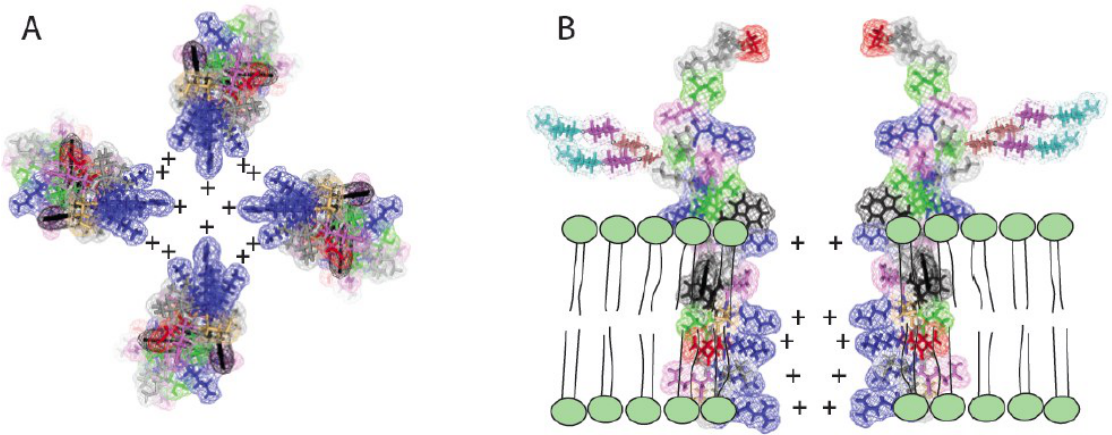
Figure 4. Effect of Ebola virus delta peptide multimerization in the lipid bilayer of cellular membranes. ( A ) A tetramer of delta peptides with the positively charged basic amino